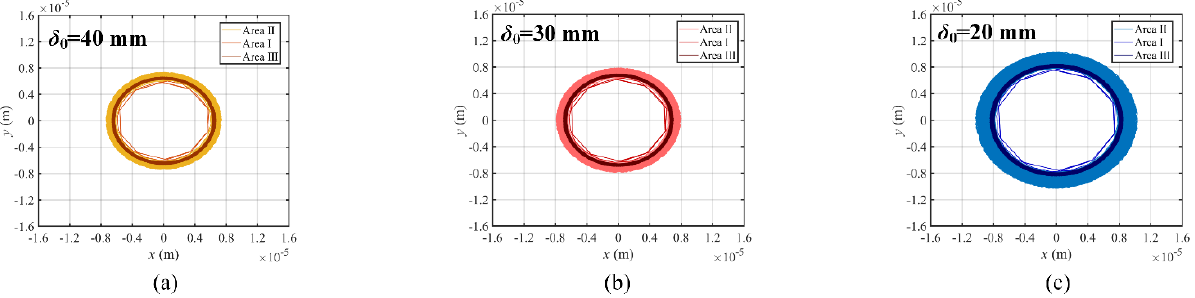
Figure 20. The time-domain figure of the generator rotor under different average air gaps between the stator and rotor. ( a ) In x -direction; ( b ) in y -direction.